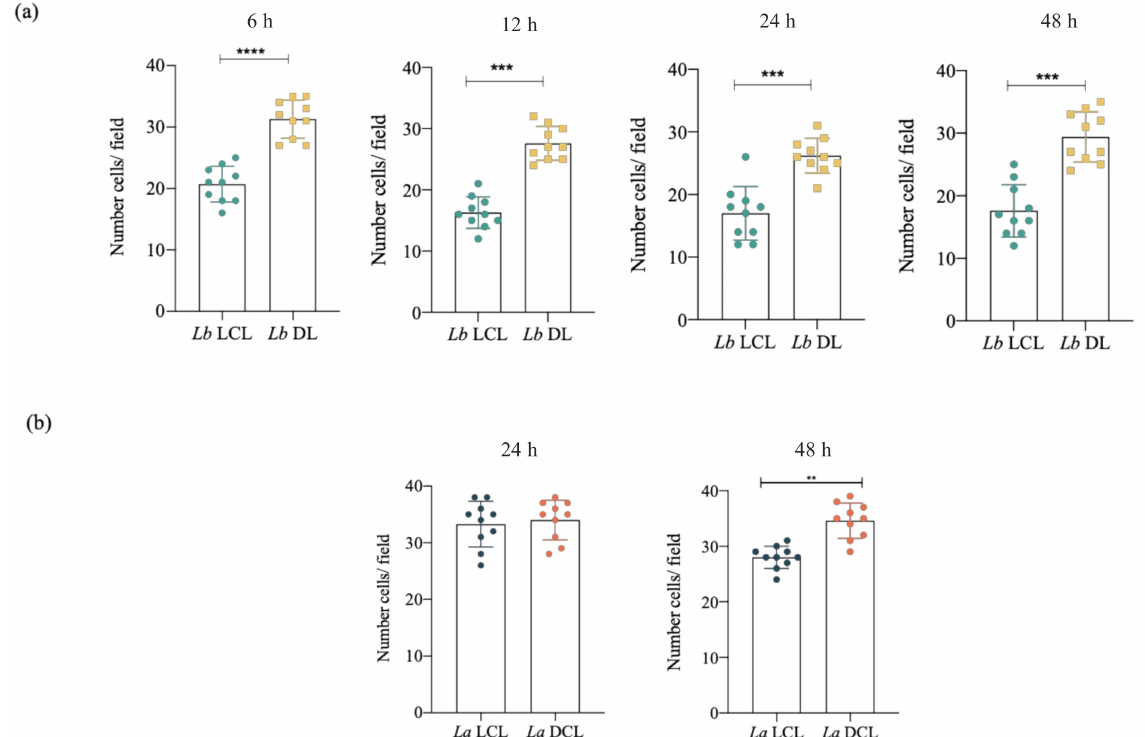
Figure 5. Infection with L. braziliensis (DL) and L. amazonensis (DCL) isolates increases hDC migration. Effects of Lb LCL, Lb DL, La LCL, or La DCL infection on hDC migration using a Boyden chamber assay with CCL3 in the lower chamber. hDCs infected (4 h) with Lb LCL, Lb DL, La LCL or La DCL were allowed to migrate for 4 h at 6, 12, 24 or 48 h post-infection. Boyden chamber membranes were washed, fixed, and incubated with DAPI for nuclear staining. Migrating cells were randomly counted (10 fields) by fluorescence microscopy. ( a ) Number of migrating cells following Lb LCL or Lb DL infection. ( b ) Number of migrating cells following La LCL or La DCL infection. ** p < 0.05; *** p < 0.001, **** p < 0.001 (Student’s t -test). Data are representative of three independent